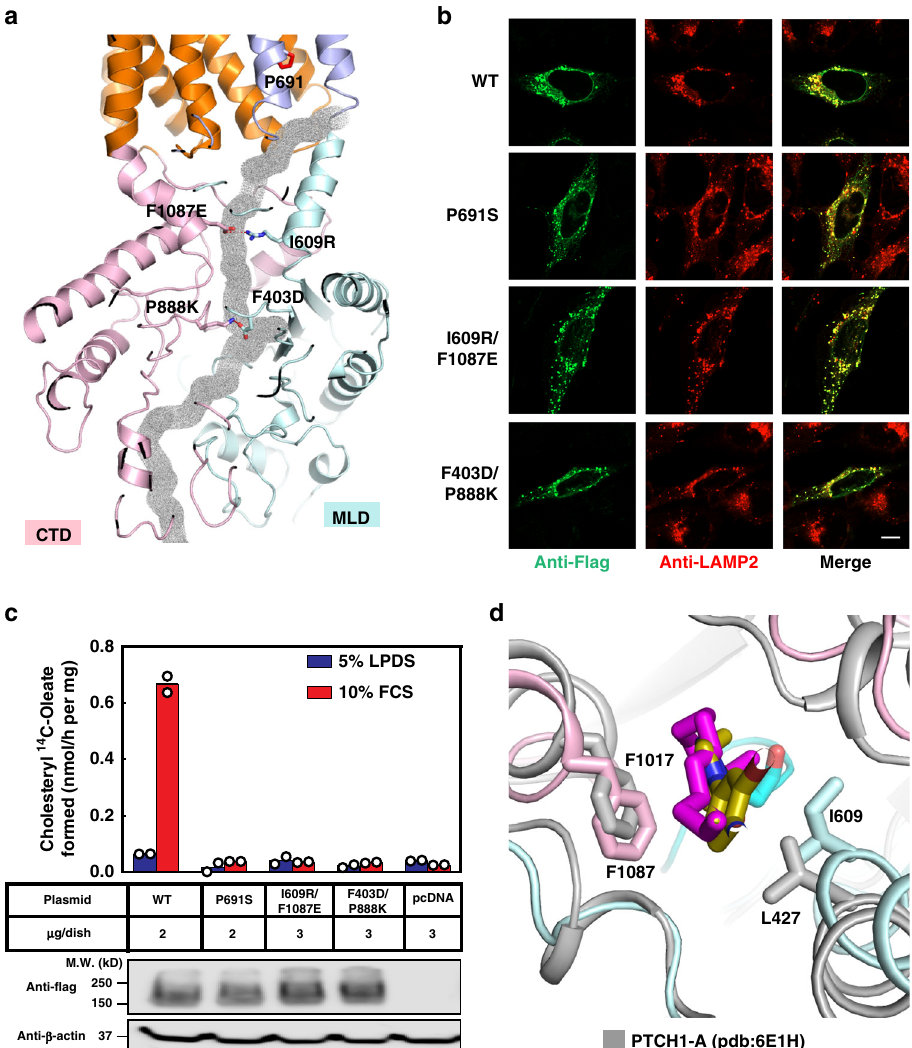
Fig. 6 Blocking the putative tunnel of NPC1 abolishes NPC1-mediated LDL-derived cholesterol transport. a The distribution of mutations used for blocking the putative tunnel. b Localization of NPC1 proteins to lysosomes. SV589 cells were transfected with the plasmids encoding Flag-tagged NPC1 and mutants as described in Methods. Cells were fi xed and double stained with 0.8 µ g/ml of rabbit monoclonal anti-Flag IgG (green) together with 1 µ g/ml of mouse monoclonal anti-LAMP-2 IgG (red), and images were merged (yellow). LAMP-2 is a marker for lysosomes. Immuno fl uorescence microscopy was performed as described in Methods. Scale bar, 10 µ m. c ACAT assays. On day 0, NPC1 − / − cells were set up in medium A with 5% FCS at 2.5 × 10 5 cells/ 60 mm dish. On day 2, monolayers were switched to fresh medium A with 5% LPDS and then transfected with the indicated plasmids encoding NPC1 or mutants using FuGENE HD as the transfection agent. After incubation for 24 h, cells were switched to medium A with 5% LPDS containing 50 µ M sodium compactin and 50 µ M sodium mevalonate. On day 4, the cells received fresh medium B containing compactin and mevalonate in the presence of either 5% LPDS or 10% FCS containing lipoproteins. After incubation for 4 h at 37 °C, each cell monolayer was pulse-labeled for 2 h with 0.1 mM sodium [ 14 C] oleate (6210 dpm/nmol). The cells were then harvested for measurement of their content of cholesteryl [ 14 C] oleate and [ 14 C] triglycerides as described in Methods. Each bar indicates the mean of duplicate incubations with individual values shown. The mean cellular content of [ 14 C] triglycerides in the presence of FCS was not signi fi cantly different in cells transfected with pcDNA3.1-NPC1, or its mutants including P691S, I609R/F1087E, F403D/P888K (10.5, 10.5, 11, 10 nmol per hr/mg protein, respectively). The bottom panel shows immunoblots of whole cell extracts (40 μ g/lane) using 1:1000 dilution of anti-Flag and 1:5000 dilution of anti- β -actin. d Structural comparison of itraconazole-bound NPC1 (colored) and PTCH1-A (gray). The conserved residues are indicated. Palmitate of Hedgehog is shown as magenta sticks. Source data are provided as a Source Data fi